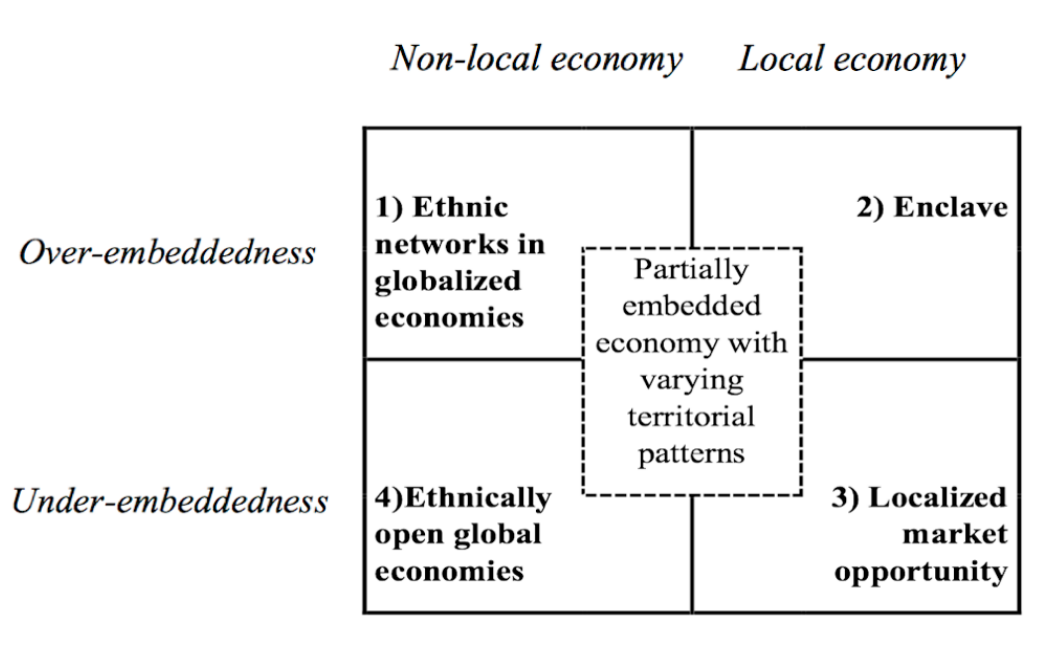
Fig. 3: Migrant Entrepreneur